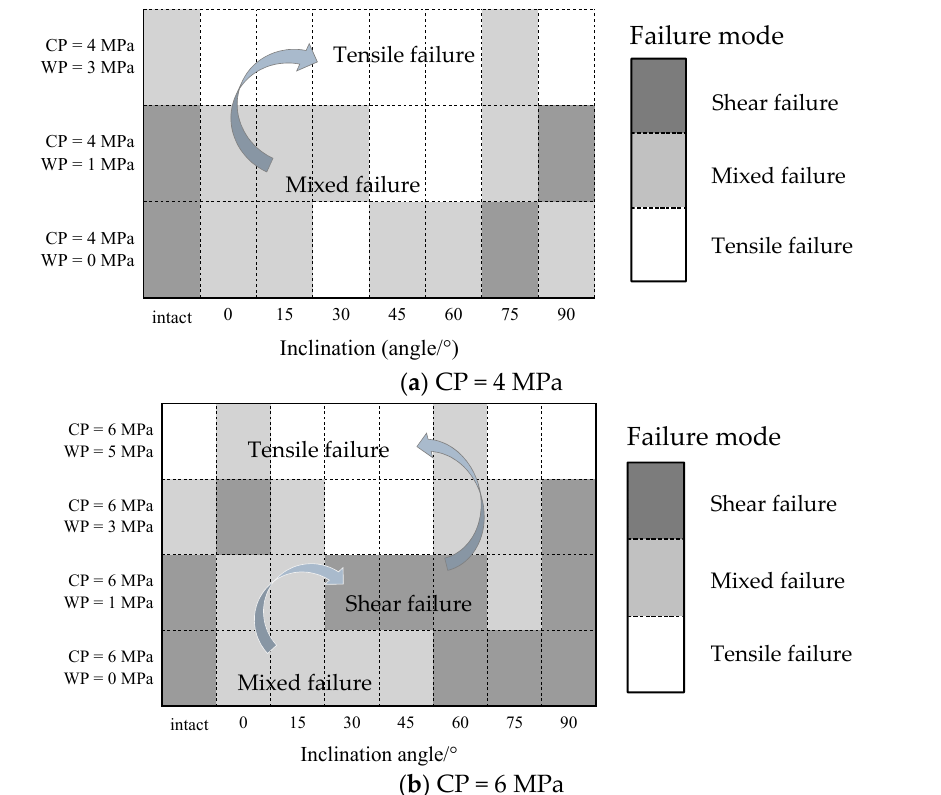
Figure 15. Failure mode of specimens under different water pressure. ( a ) Under 4 MPa confining pressure; ( b ) under 6 MPa confining pressure. Table 3. Summary of all crack types observed in hydraulic coupled triaxial test.